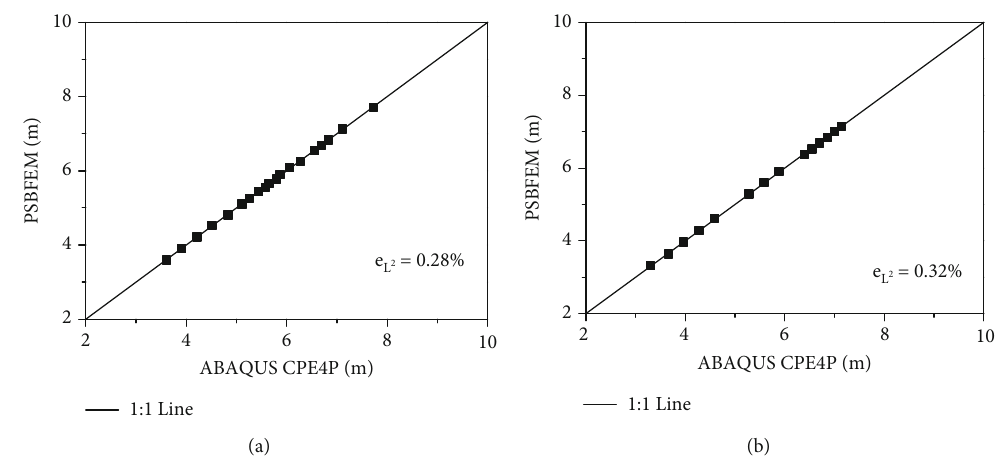
Figure 8: Comparison of the PSBFEM and FEM in the water head: (a) left edge; (b) right edge.